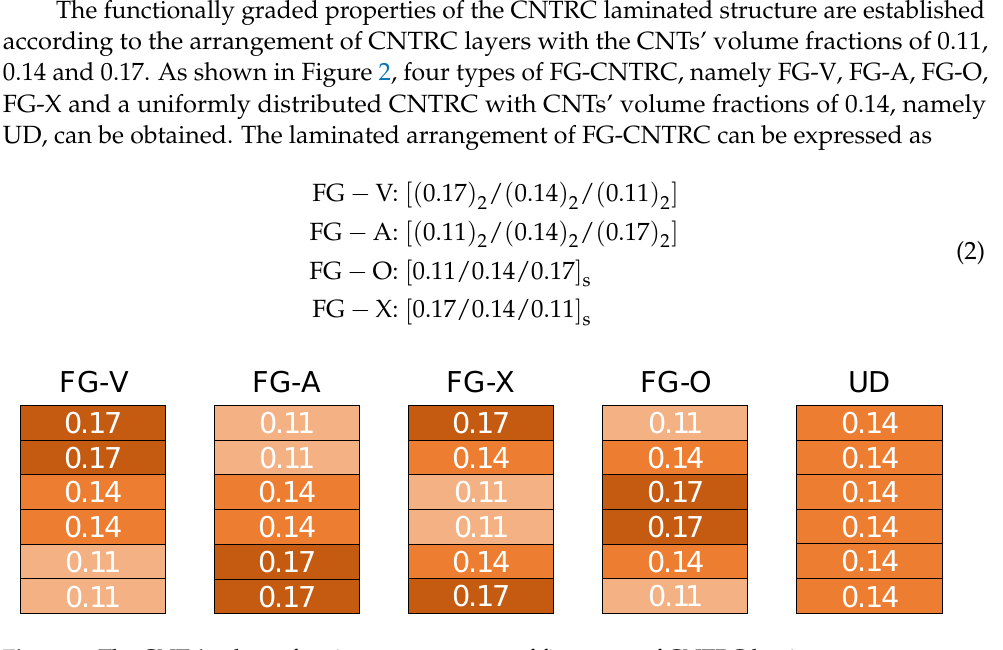
Figure 2. The CNTs’ volume fractions arrangement of five types of CNTRC